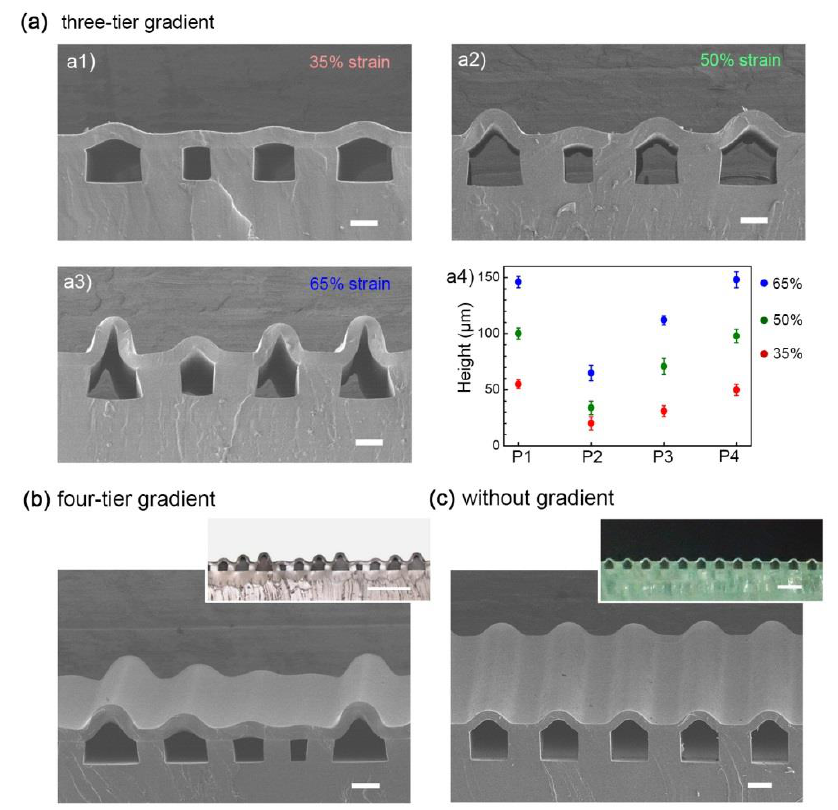
Figure 4. ( a1 – a3 ) Gradient modulation by tuning strains and ( a4 ) the corresponding height modification. ( b , c ) Another two typical surfaces with ( b ) four-tier gradient and ( c ) without gradient prepared by the method. Scale bars: ( a – c ) 100 µ m, (inset) 500 µ